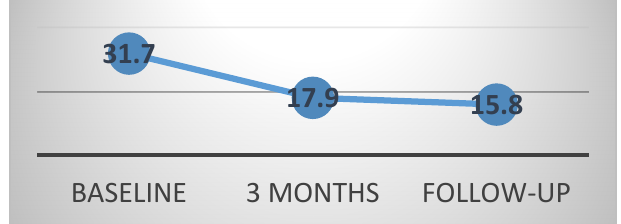
Figure 2. Changes in CM over time.